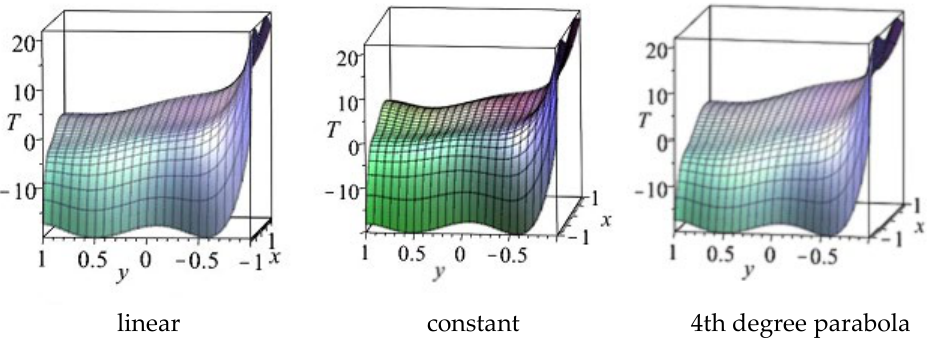
0.5 °C , 𝑇𝑇 𝜌𝜌 = − 19 𝑣𝑣 𝑎𝑎 =